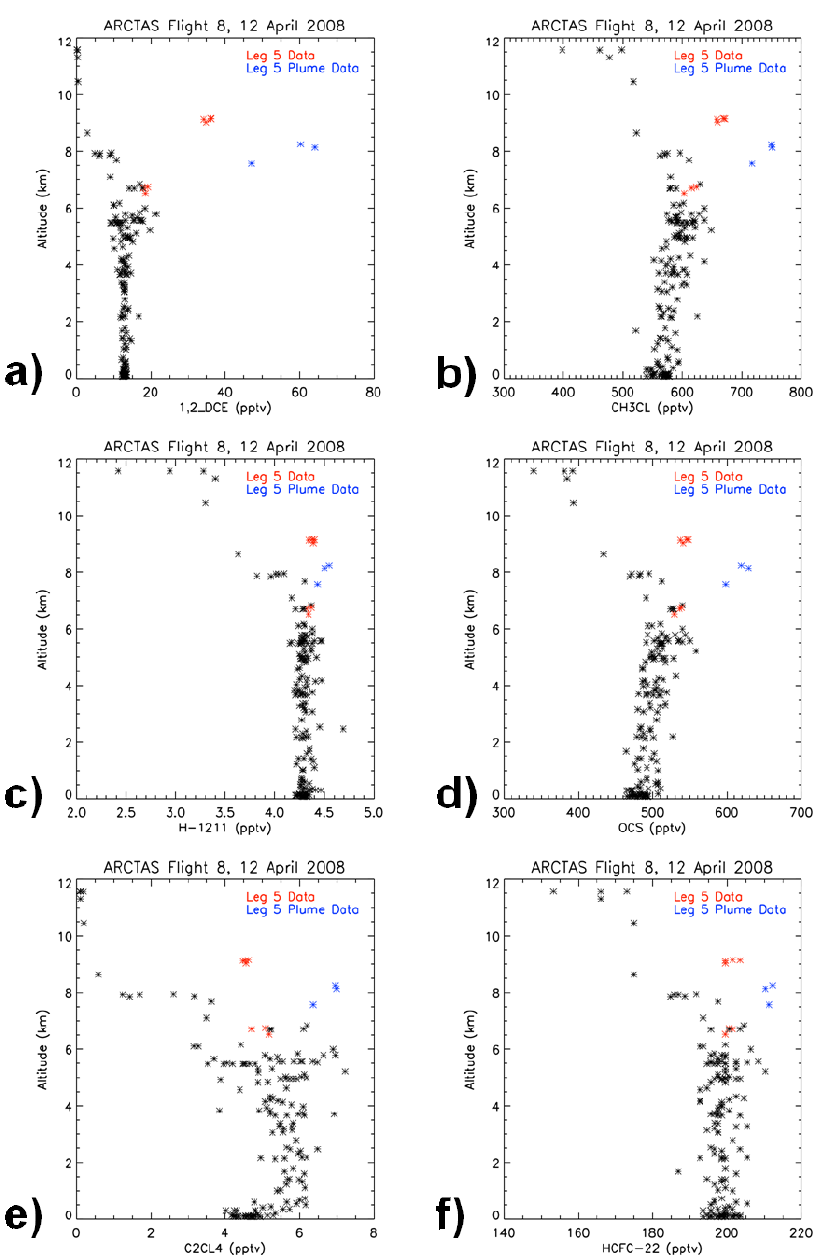
Fig. 5. Vertical distributions of data from flight 8 on 12 April 2008 for (a) 1,2-DCE, (b) CH 3 Cl, (c) H-1211, (d) OCS, (e) C 2 Cl 4 , and (f) HCFC-22. Red points are data from leg 5. Blue points also are from leg 5 but represent the sampled plume. Black points represent the remaining legs of flight 8.